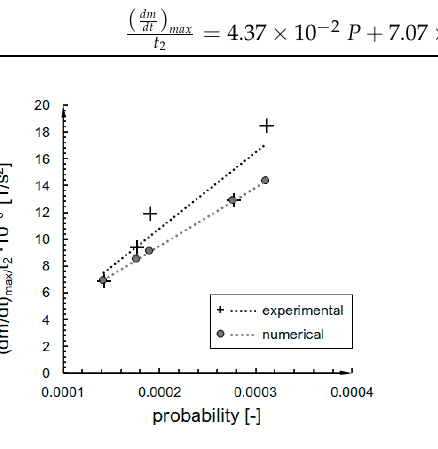
Figure 14. The dependence of ( dm / dt ) max / t 2 ratio on probability of an effective collision for experi- mental and numerical approach.